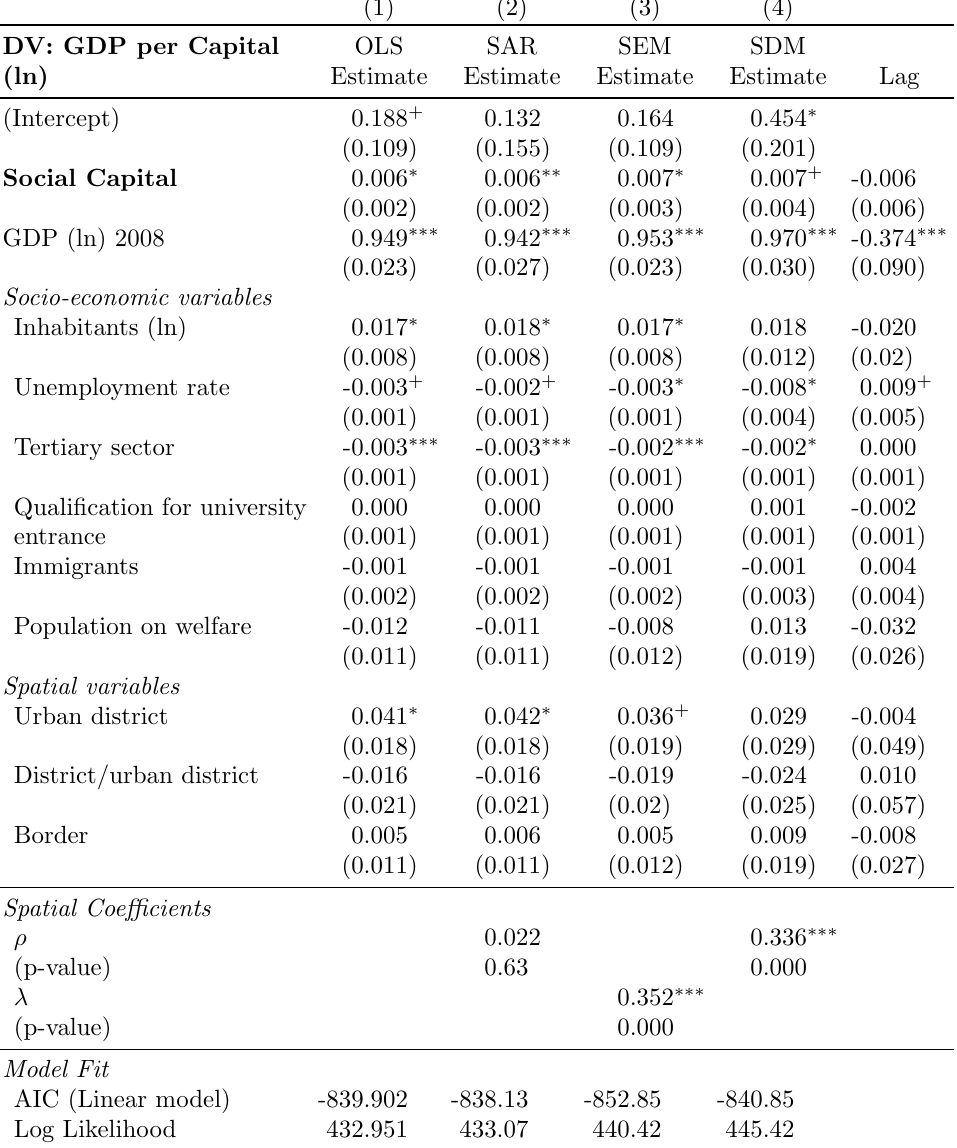
Table A.2: Explaining regional differences in economic well-being using spatial regression models, robustness test with lagged GDP t −